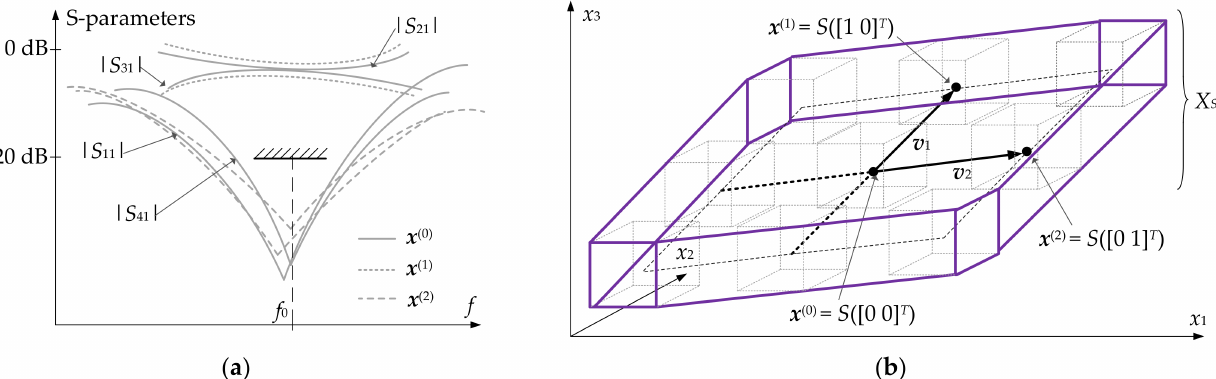
Figure 6. Yield optimization of microwave couplers by means of performance-driven surrogates: ( a ) scattering parameters of an exemplary coupler at the nominal design x (0) , design x (1) (spoiled power split), and design x (2) (improved –20 dB bandwidth); for clarity, only the selected S-parameters are shown for x (1) (| S 21 |, | S 31 |) and x (2) (| S 11 |, | S 41 |). These designs determine the directions of the most significant response changes (from the point of view of yield manipulation). ( b ) The designs x (0) to x (2) form a parameterized surface S ( t ). The union of intervals S I ( t ) (cf. (21)) forms surrogate model domain X S